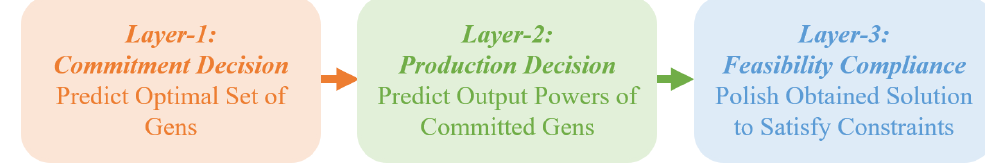
Figure 3. The Proposed Multi-Layer SCUC Algorithm.